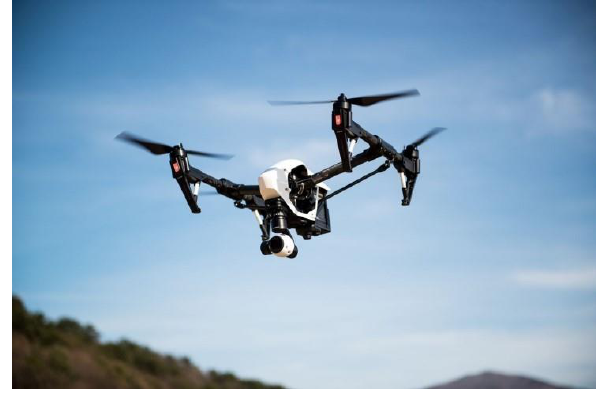
Figure 2.Inspire